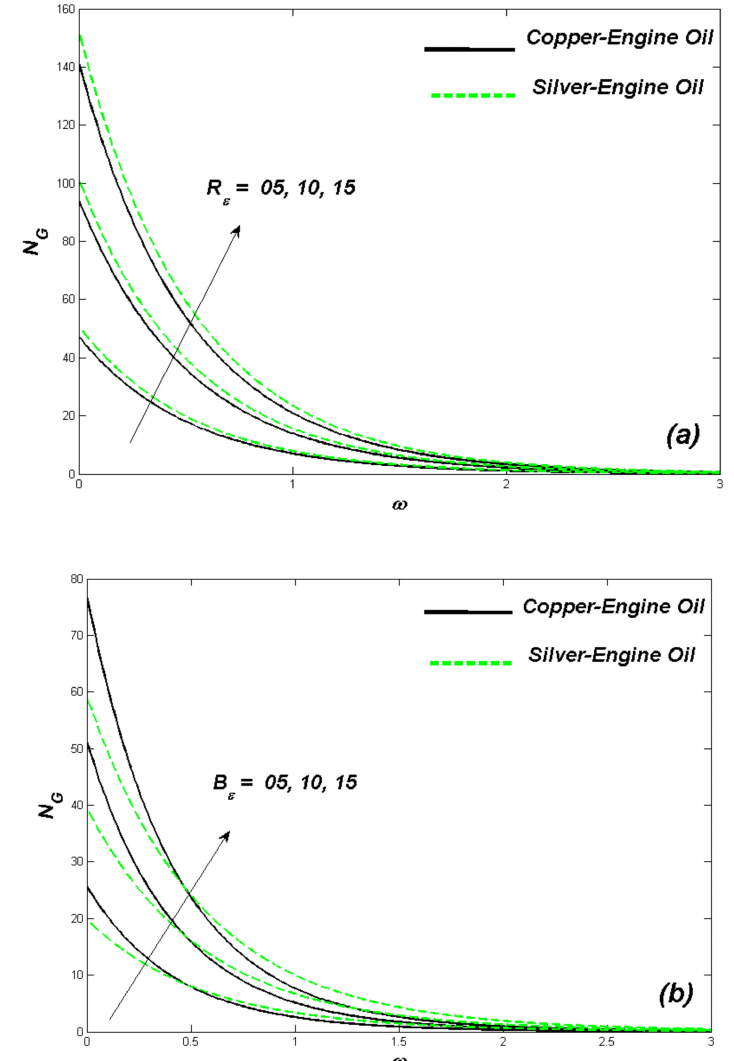
Figure 6. ( a ). Velocity change with R ε . ( b ) Temperature change with B ε . 1 2 x ) and Nusselt Number ( N u Re Table 4. Skin friction ( C f Re